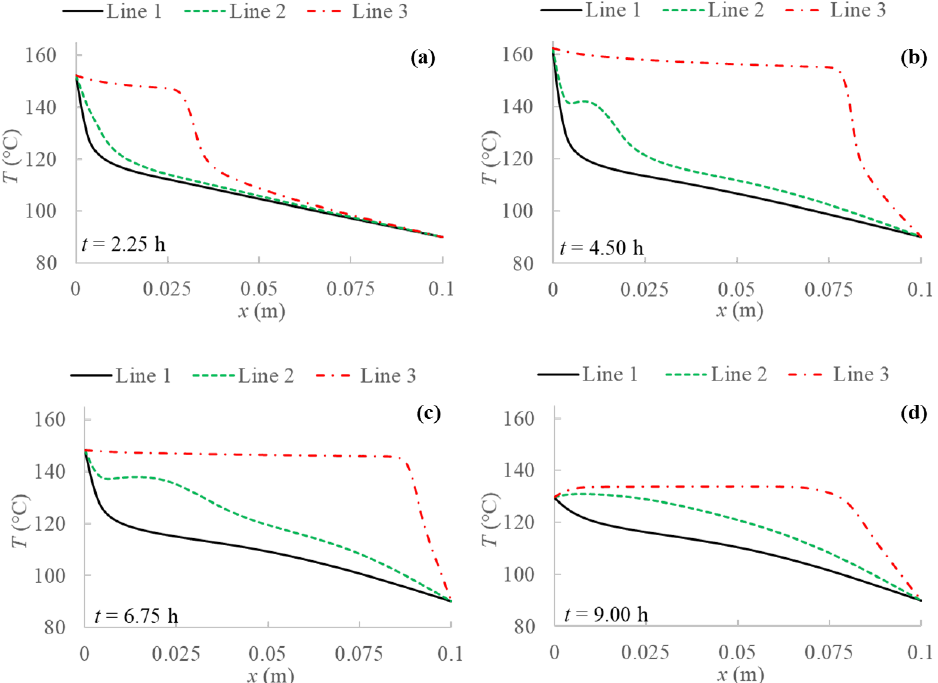
Figure 5. Temperature profiles for 2D model with natural convection and boundary condition (BC) 1 evaluated at three different PCM transversal sections: Line 1 ( y = 0 m); Line 2 ( y = 0.05 m); Line 3 ( y = 0.1 m), and at different evaluation times: ( a ) after 2.25 h; ( b ) after 4.50 h; ( c ) after 6.75 h; ( d ) after 9.00 h from the simulation beginning respectively.